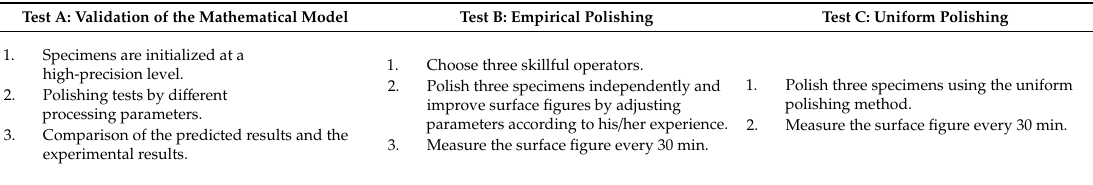
Figure 7. High-speed polishing experiments.